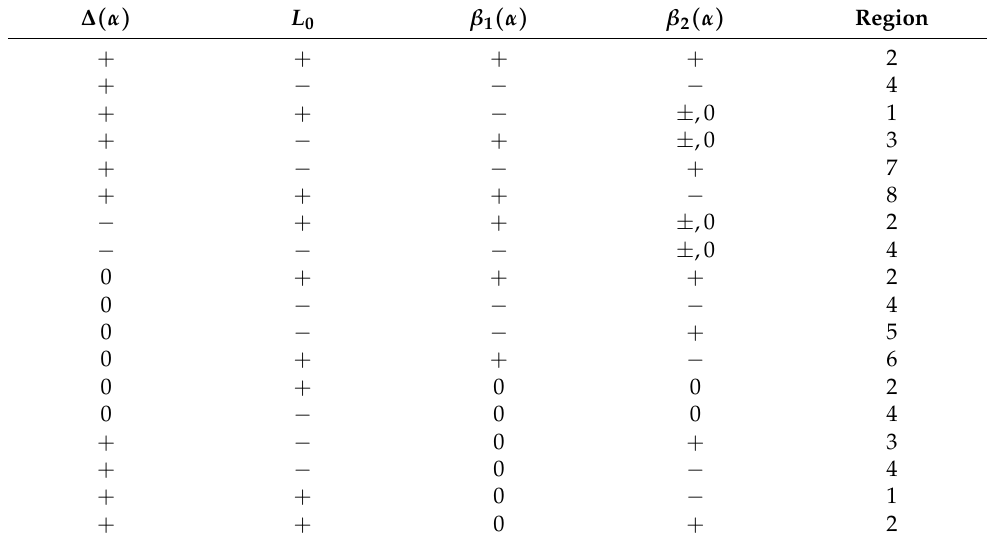
Table A1. Correspondence between ∆ , β 1,2 , L 0 and the generic phase portraits [4].